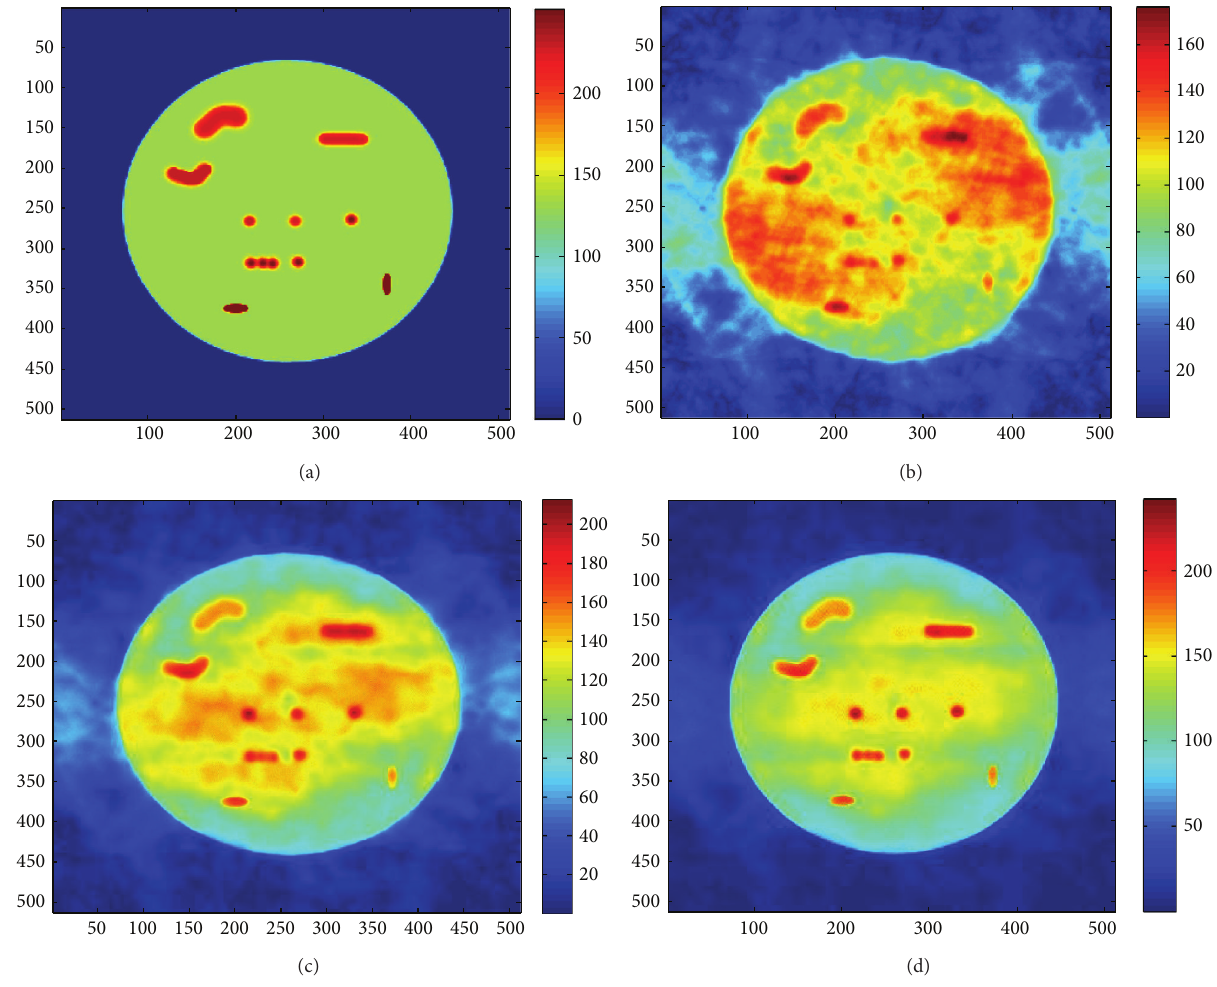
Figure 4: (a) Synthetic solar image. (b) Reconstructed image using CSC algorithm (RelErr = 83.1%, SNR = 23.5). (c) Reconstructed image using CS algorithm (RelErr = 34.3%, SNR = 32.9). (d) Reconstructed image using our method (RelErr = 21.3% SNR =